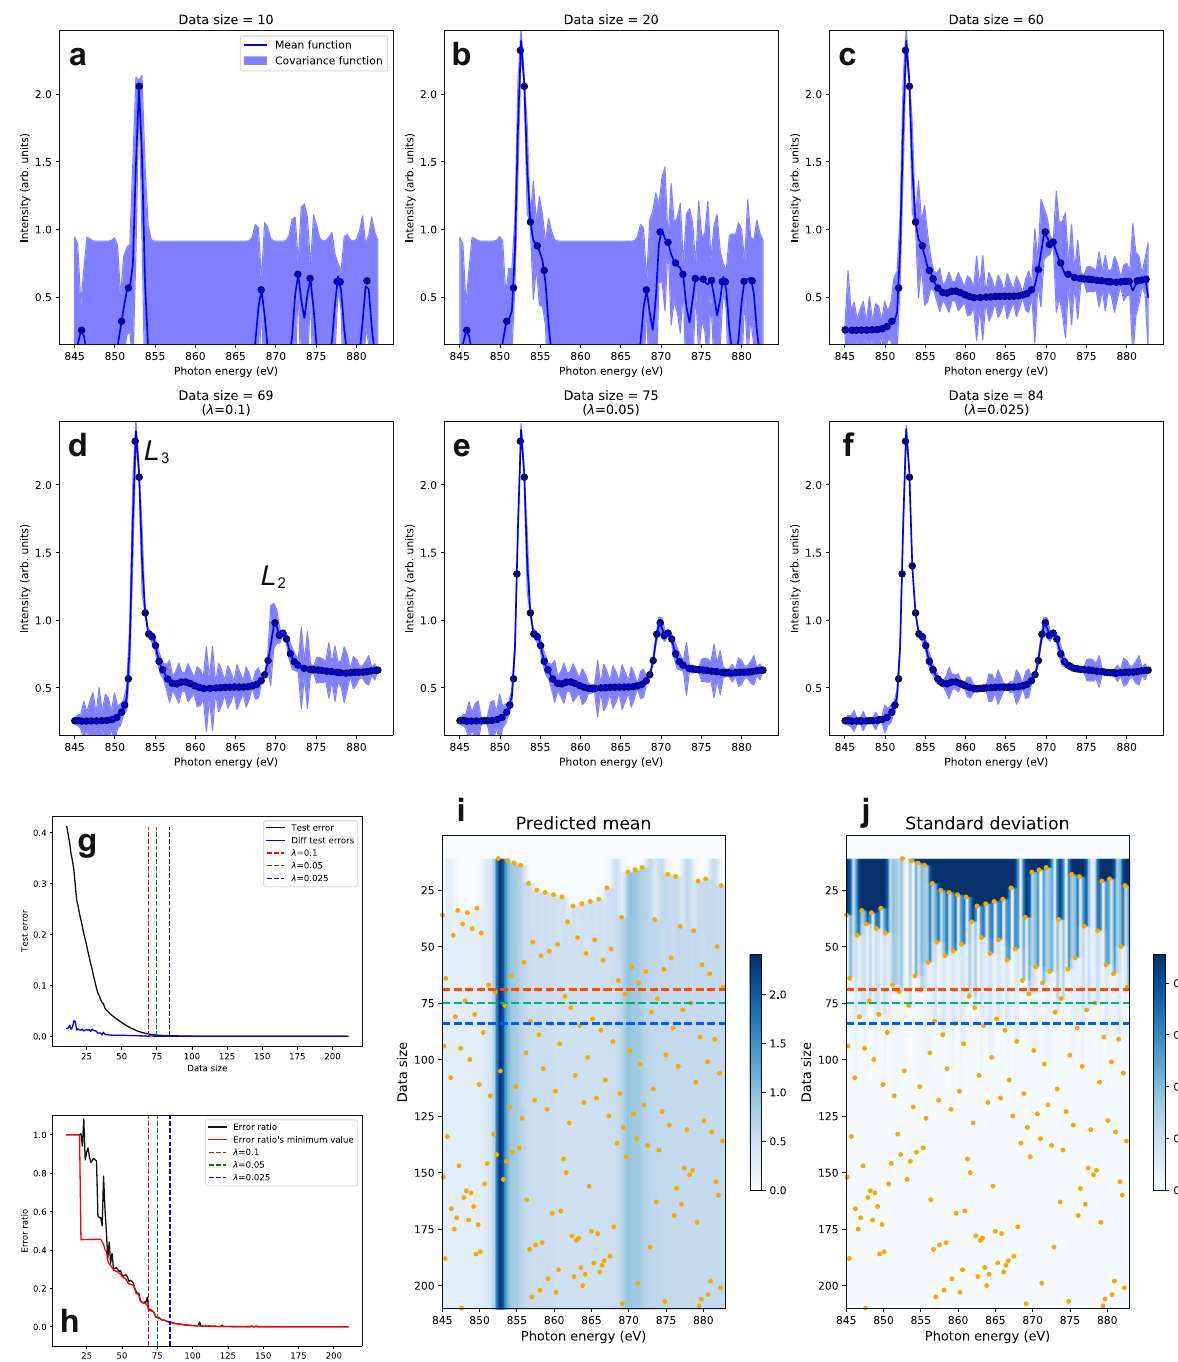
Fig. 4 Spectral measurement of experimental Ni L 2,3 XAS with active learning. Gaussian process regression (GPR) a for data size = 10 (initial sampling), b data size = 20, c data size = 60, d data size = 69 (stopping criterion with λ = 0.1), e data size = 75 (stopping criterion with λ = 0.05) and f data size = 84 (stopping criterion with λ = 0.025). Black full circles, blue solid curves and blue shades indicate the measured data points, mean function of the GPR, and covariance function of the GPR, respectively. g Error ratio versus data size. Black and red curves indicate the error ratio and their minimum value, respectively. h Test error versus data size. Black and blue curves indicate test error and difference of test error between n -th and ( n − 1)-th sampling. In g and h , red, green and blue vertical dashed lines indicate stopping timings for λ of 0.1, 0.05 and 0.025, respectively. i Heat maps of the predicted mean and j standard deviation versus data size. Red, green and blue horizontal dashed lines indicate stopping timings for λ of 0.1, 0.05 and 0.025, respectively. Orange markers indicate sampled energy points in each AL